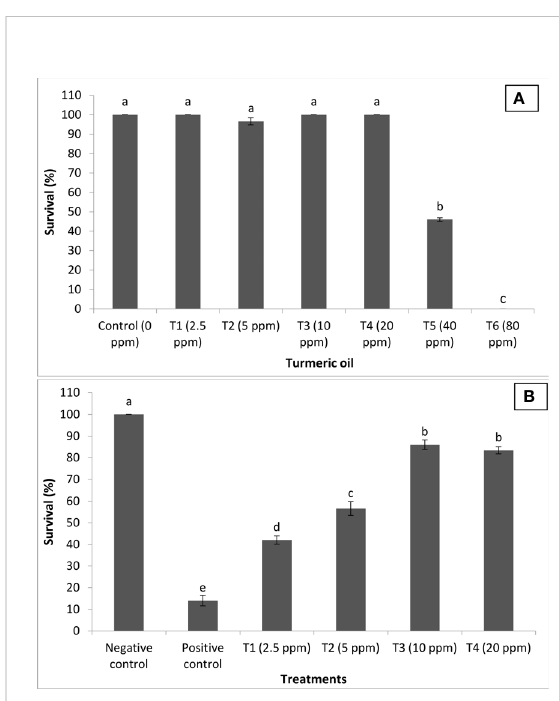
FIGURE 6 Curcuma longa (turmeric) oil treatment protects Pangasianodon hypophthalmus fi ngerlings against I. multi fi liis and A. hydrophila co-infection. (A) Toxicity of turmeric oil to P. hypophthalmus fi ngerlings. The fi ngerlings were treated with oil extract at the indicated doses for 120 h. The non-treated fi ngerlings served as control. Survival was recorded 120 h post-treatment. Error bars represent the standard error of fi ve replicates; different letters indicate signi fi cant differences ( p < 0.001). (B) Survival (%) of turmeric oil-treated P. hypophthalmus fi ngerlings after 120 h of co-infection. The fi ngerlings were treated with oil extract at the indicated doses in the I. multi fi liis and A. hydrophila co-infected P. hypophthalmus . Non-pretreated fi ngerlings that were either co-infected (positive control) or not (negative control) served as controls. The error bars represent the standard error of fi ve replicates; different letters indicate signi fi cant differences between treatment groups ( p <